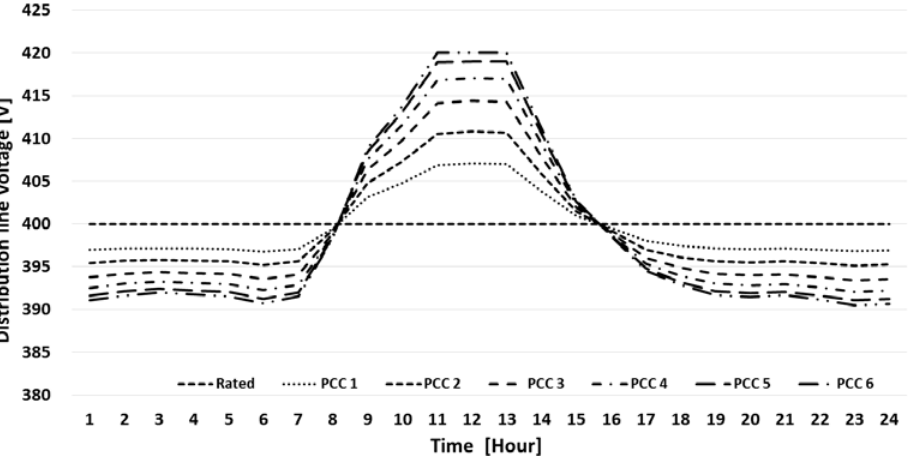
Figure 12. Complementary ESS operation for voltage